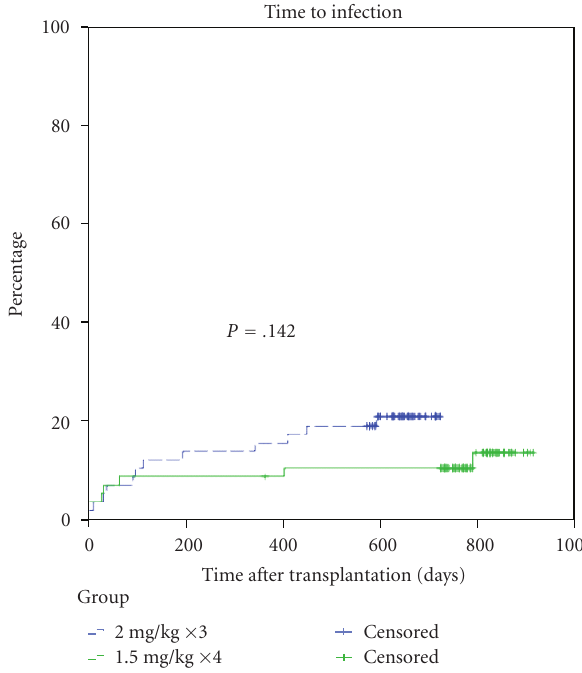
Figure 1: Incidence of infection. The two-year incidence of infection was similar between the groups, 12% in the 1.5mg/kg group and 20% in the 2 mg/kg group, P = .